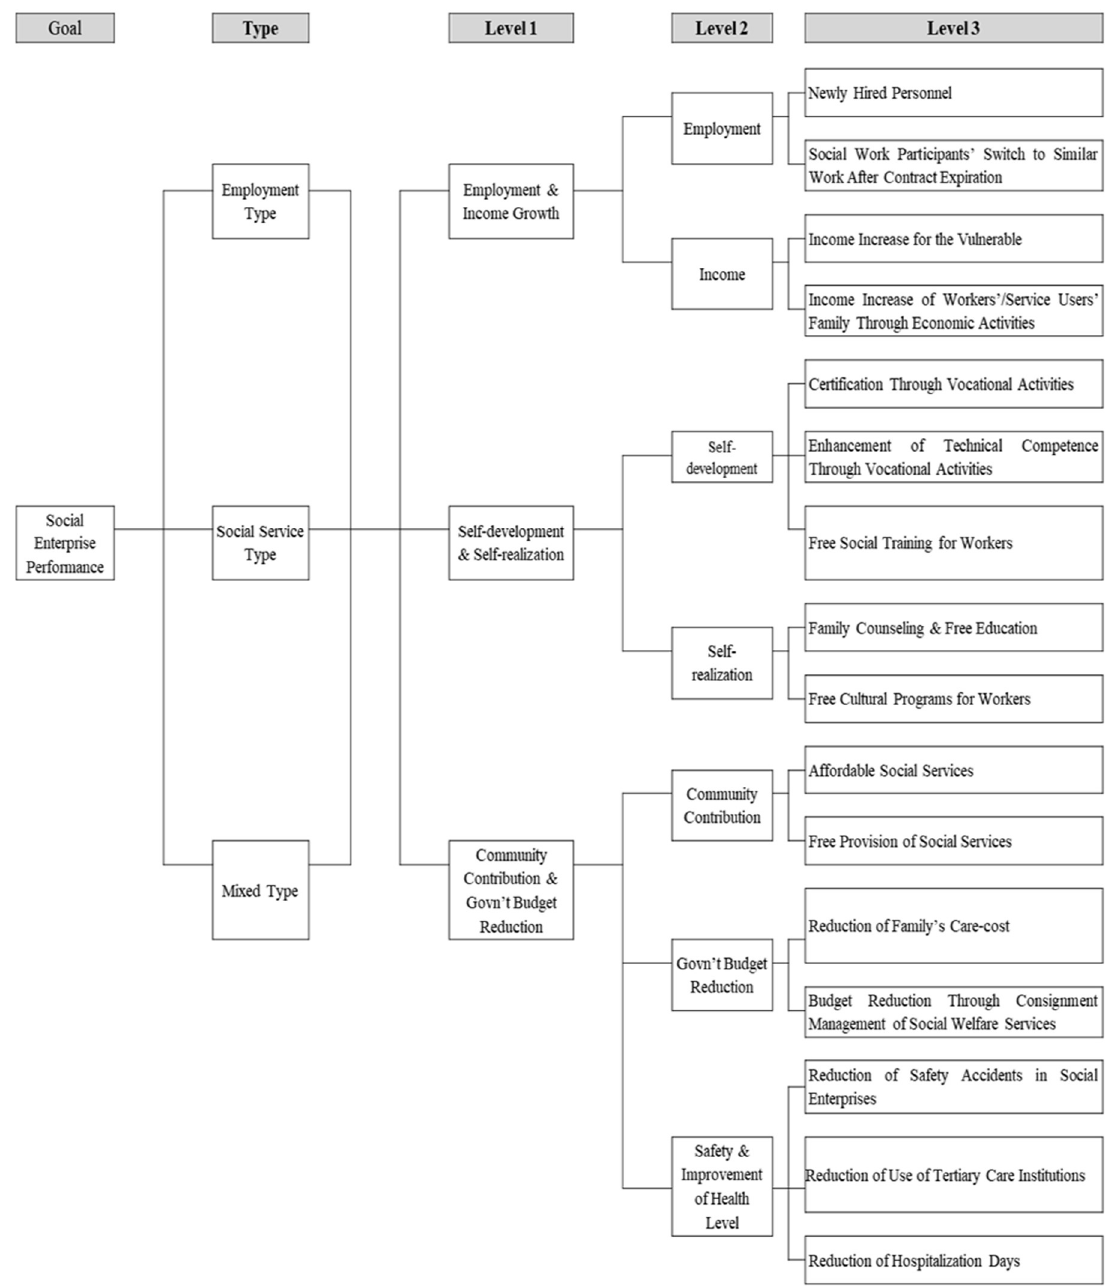
Figure 1. AHP System.